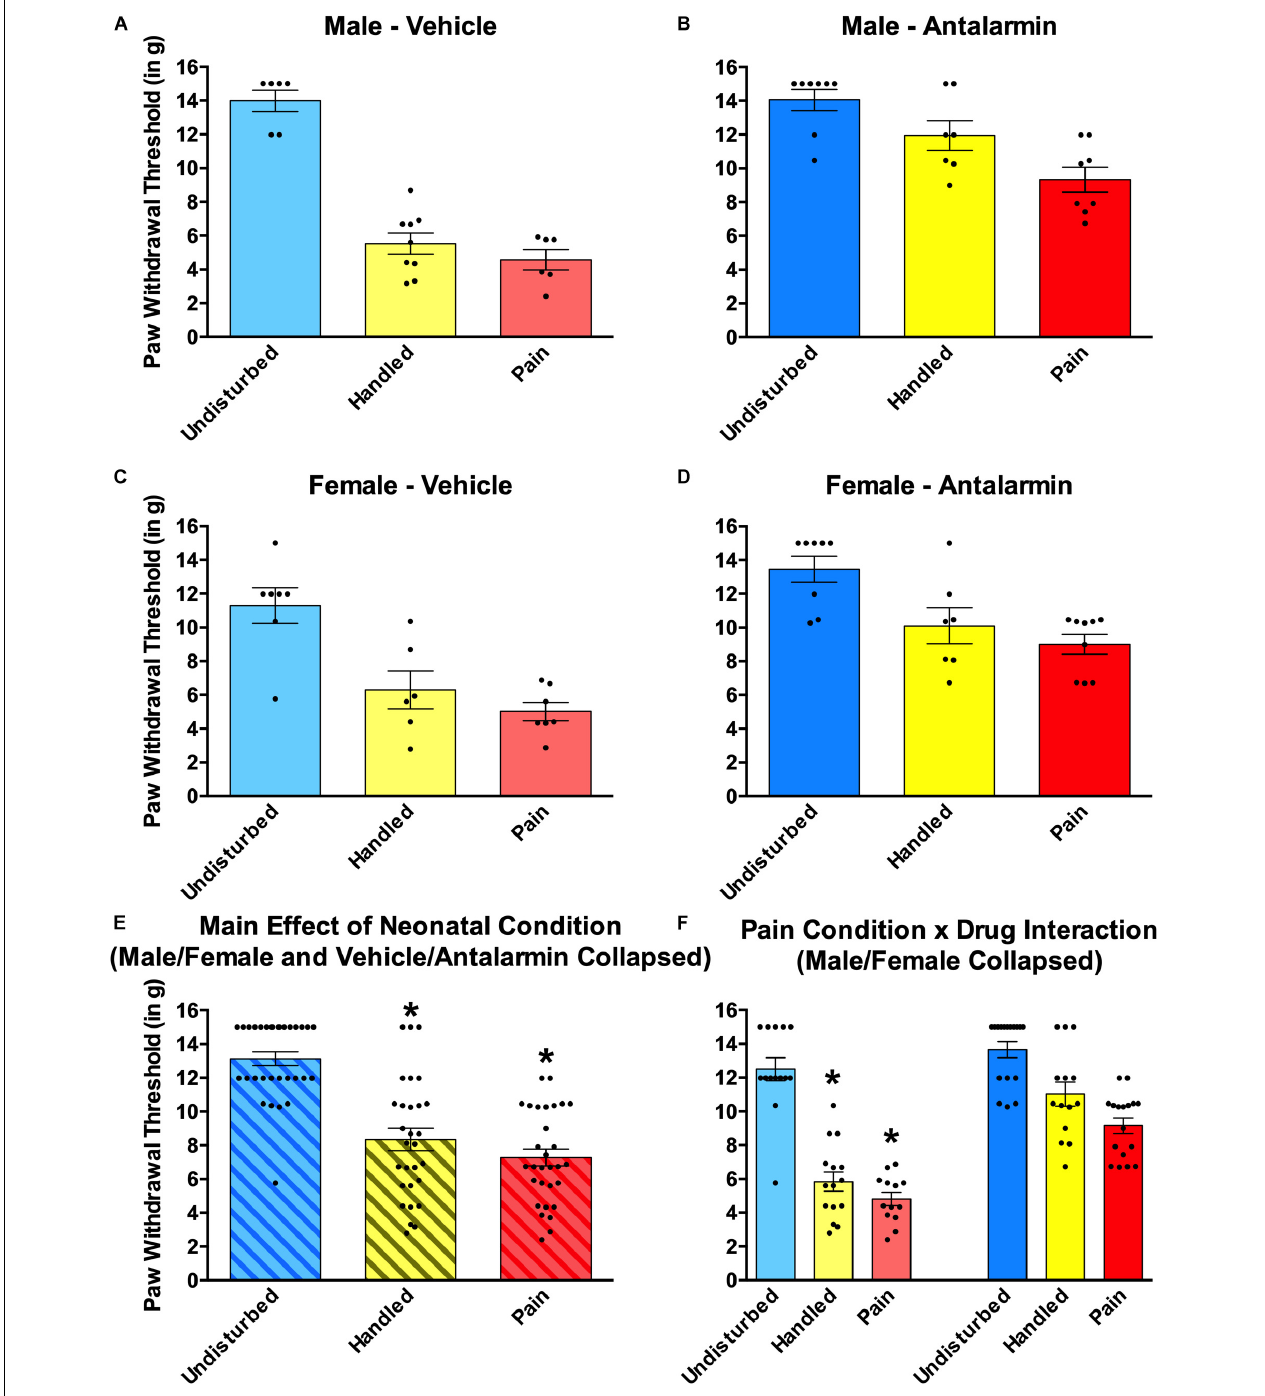
FIGURE 6 | Effects of Antalarmin on paw withdrawal thresholds on the von Frey mechanical allodynia measure in neonatally manipulated rats for Experiment 1. Top two panels represent male, (A) vehicle-treated rats (Undisturbed—N = 8; Handled—N = 12; Pain—N = 9) and (B) Antalarmin-treated rats (Undisturbed—N = 11; Handled—N = 10; Pain—N = 10). The middle two panels represent female, (C) vehicle-treated rats (Undisturbed—N = 7; Handled—N = 9; Pain—N = 8), and (D) Antalarmin-treated rats (Undisturbed—N = 8; Handled—N = 9; Pain—N = 8). The bottom two panels represent (E) the same data collapsed across sex and drug treatment to show the main effect of neonatal condition and (F) the same data collapsed across sex but not drug to show the neonatal condition and drug interaction. These data indicated that neonatal manipulation creates a general effect of tactile hypersensitivity in both male and female rats, and this effect was reversed by Antalarmin treatment in both Handled and Pain conditions. Data are presented as means with error bars as ± SEM; *denotes significant ( p < 0.05) difference between indicated groups.